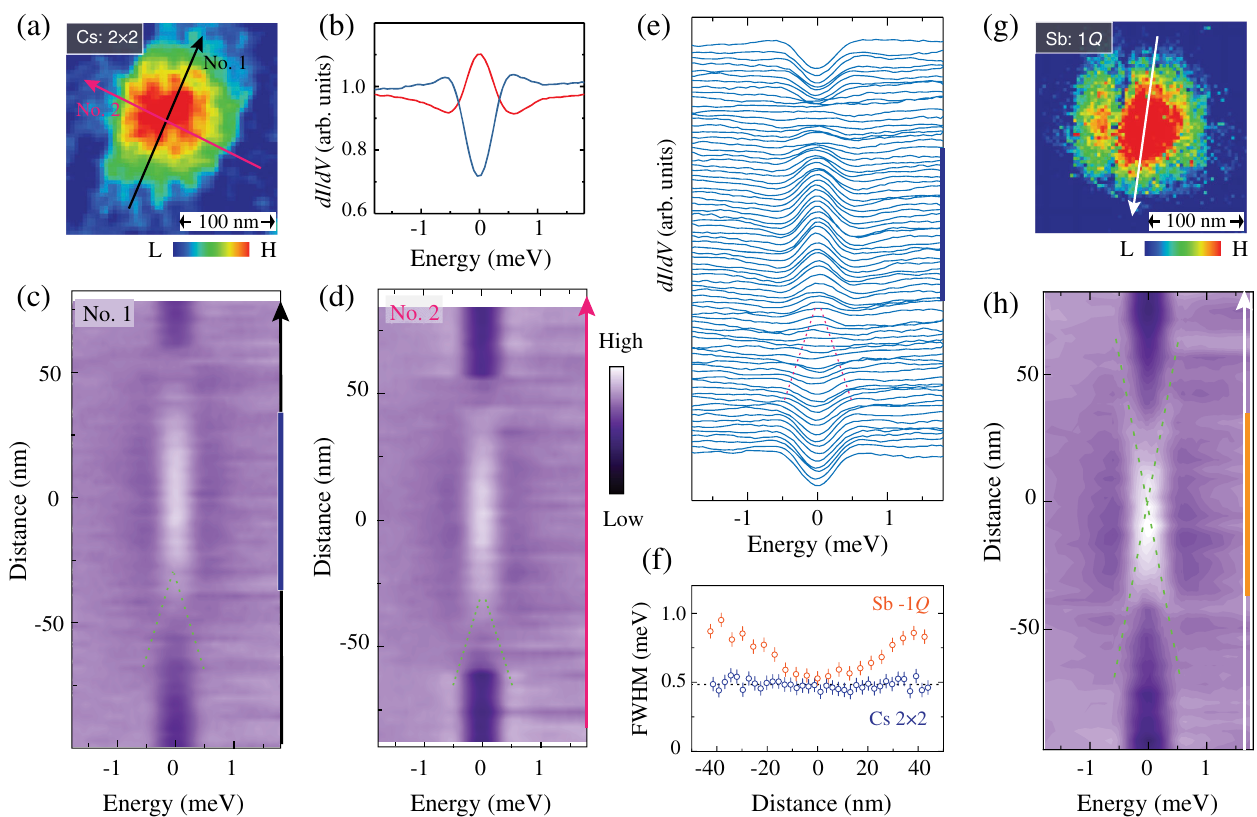
FIG. 4. (a) dI=dV map showing a superconducting vortex on the Cs surface with 3 Q − 2 × 2 CDW. (b) Tunneling spectra obtained in the vortex core (red) and outside the vortex (dark blue). (c),(d) Color map of the spatially resolved dI=dV spectra across the vortex. The traces are marked by the dark and pink arrows as shown in (a). (e) The waterfall plot of (c), vertically offset for clarity. (f) Spatial dependence of FWHM of the ZBCP when moving away from the vortex core for Cs surface (blue) and Sb surface (orange). The error bar denotes the energy step used in the measurements. (g) dI=dV map showing a vortex on the Sb surface with additional 1 Q -CDW. (h) Spatial evolution of the dI=dV spectra across the vortex. Dashed lines in (c) – (e) and (h) track the peak splitting. We note that the splitting of the peak is not clear near the starting point due to the limit of energy resolution; therefore, we track the visible splitting peaks near the vortex edge and use linear extrapolation to obtain the dashed lines (see Figs. S10 and S13 in Supplemental Material [31]). STM setup condition: (a) V S ¼ − 5 mV, I t ¼ 200 pA, V m ¼ 0 . 5 mV, (g) V S ¼ − 6 mV, I t ¼ 200 pA, V m ¼ 0 . 5 mV, (c),(d),(h) V ¼ − 5 mV, I ¼ 200 pA, V ¼ 0 . 1 S t m